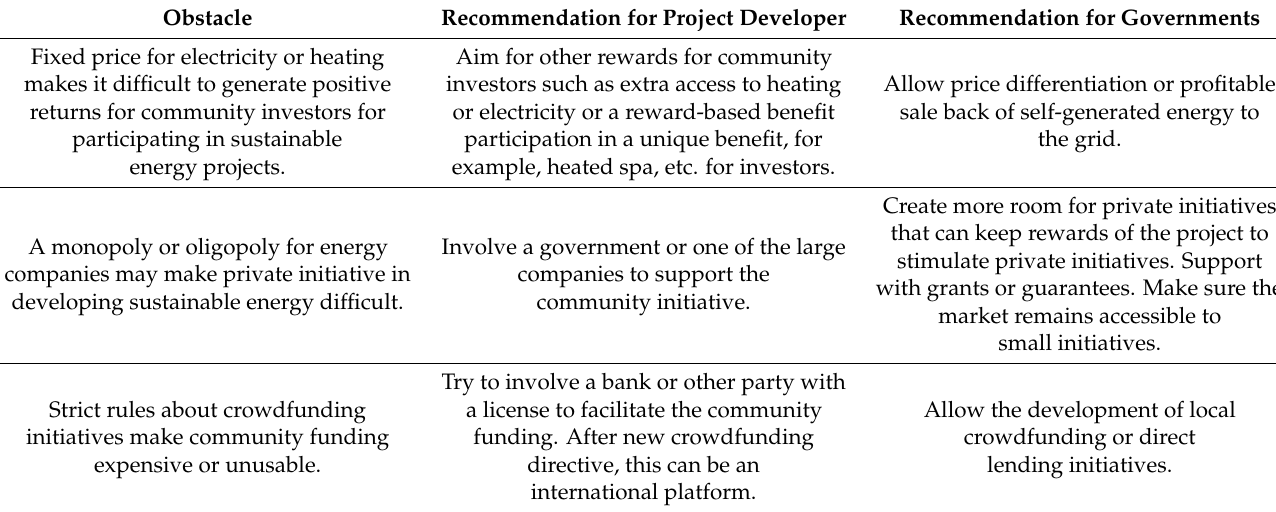
Table 4. Regulatory frameworks recommendations for project developers and